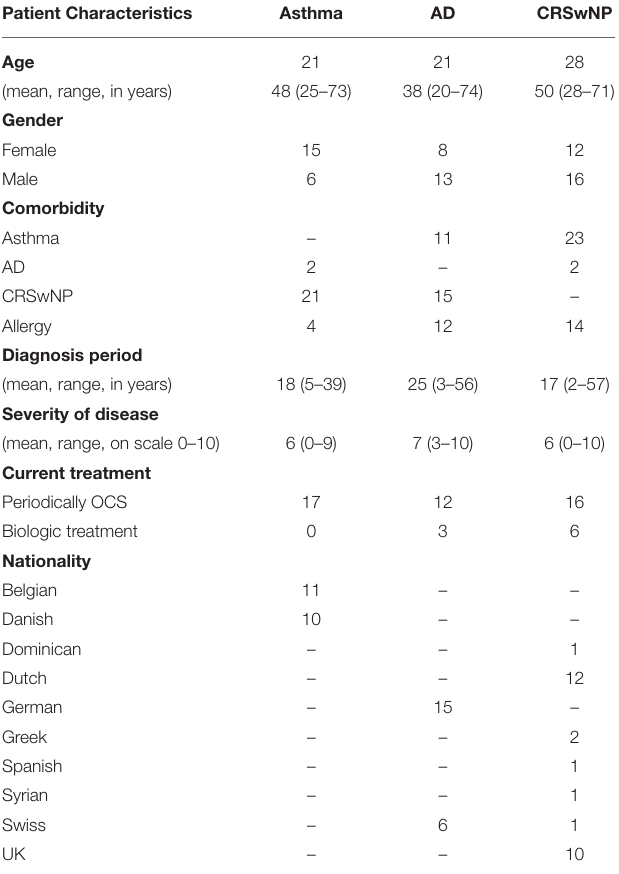
TABLE 1 | Overview of patient characteristics. Patient